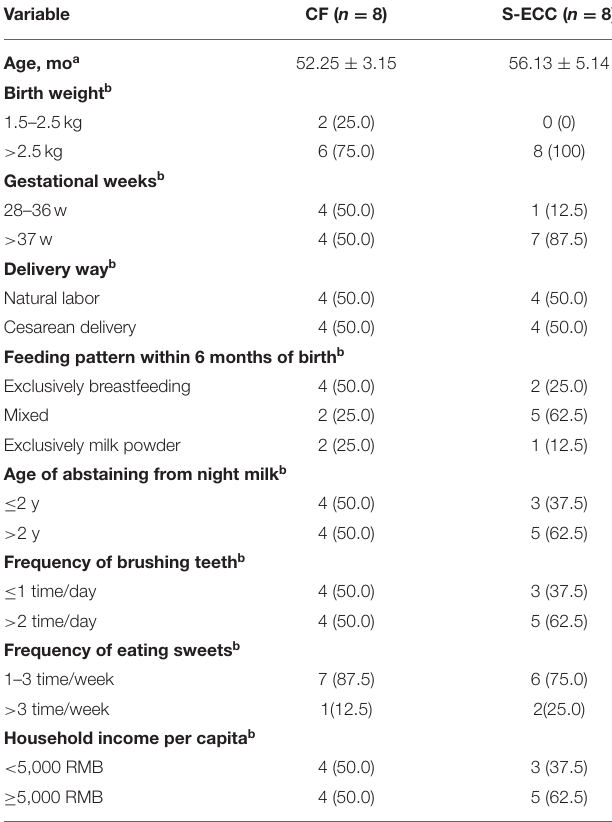
TABLE 1 | Comparison of the socioeconomic background and behavior differences of two groups of